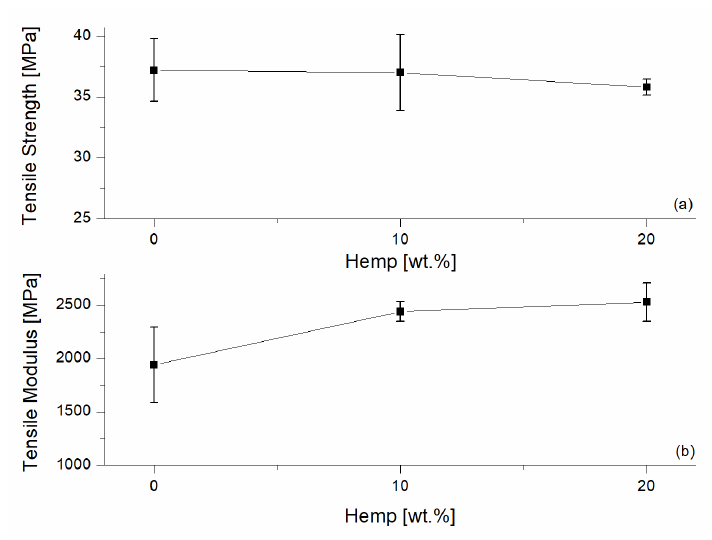
Figure 6. Tensile testing results of the reinforced 60/40 PP/LV blends with different contents of hemp fibers. ( a ) Tensile Strength; ( b ) Tensile Modulus.